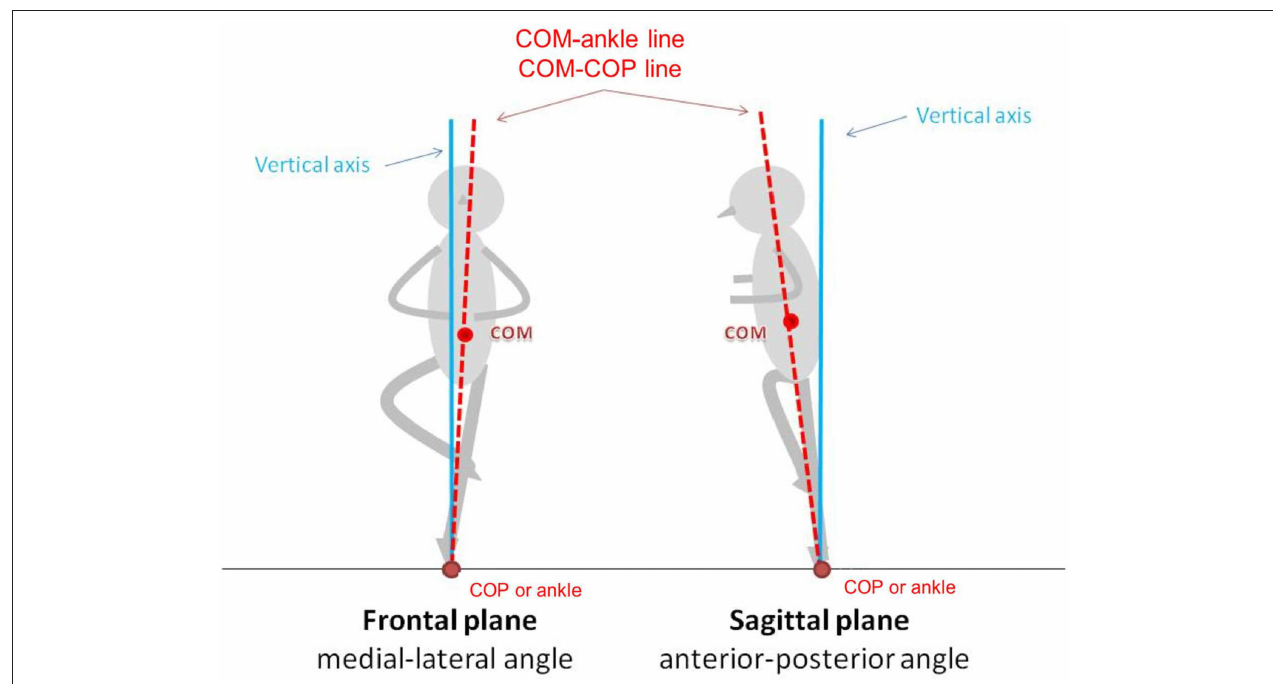
FIGURE 2 | COM–COP and COM-ankle inclination angles in the frontal and sagittal planes.